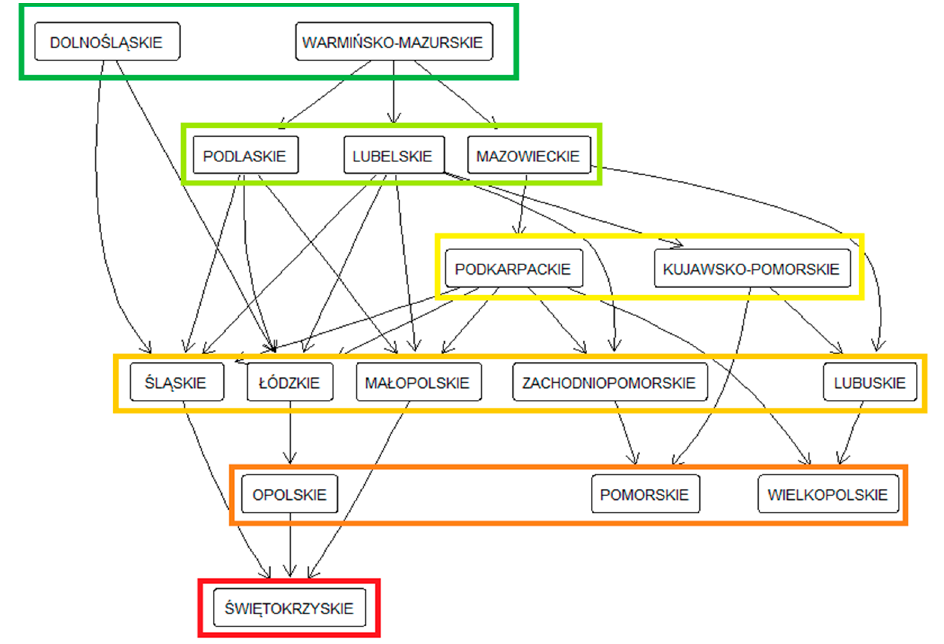
Figure 1. Partial ranking of voivodeships in terms of biogas and biomass efficiency for 2012.